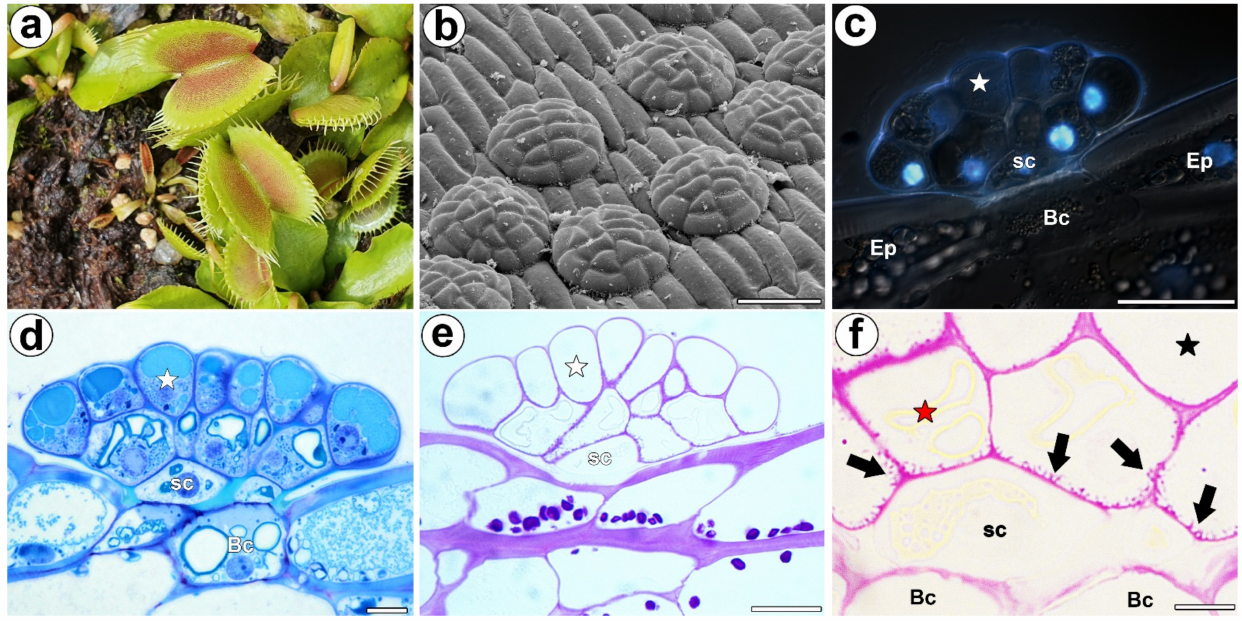
Figure 1. Morphology of a D. muscipula trap. ( a ) Traps of D. muscipula . ( b ) Morphology of the digestive gland, bar 50 µ m. ( c ) Structure of the digestive gland (stained with DAPI, blue fluorescence combined with Nomarski contrast): secretory cell (star), stem cell (sc), basal cell (Bc), epidermal cell (Ep), bar 20 µ m. ( d ) A semi-thin section of the digestive gland: secretory cell (star), stem cell (sc), basal cell (Bc), bar 20 µ m. ( e ) The digestive gland, PAS reaction: secretory cell (star), stem cell (sc), bar 20 µ m. ( f ) The digestive gland, PAS reaction: cell wall ingrowths (black arrows), secretory cell from external layer of gland head (red star), secretory cell from inner layer of gland head (black star), stem cell (sc), basal cell (Bc), bar 2 µ